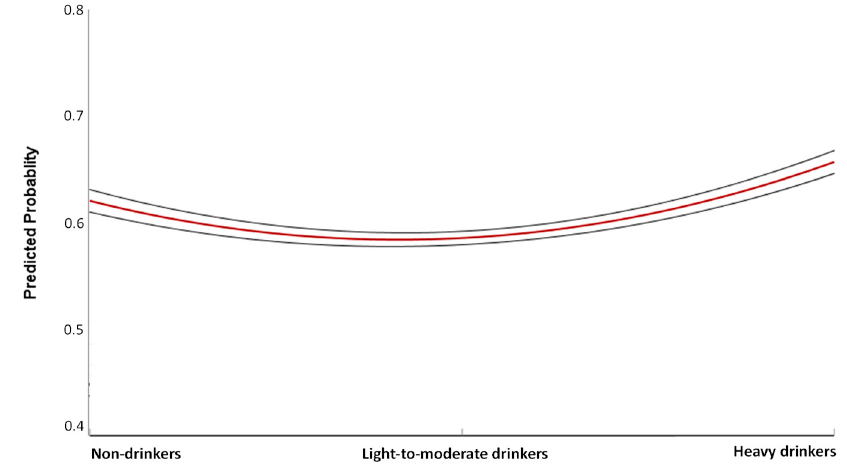
Figure 2. Relationship between categories of alcohol consumption and poor cardiovascular health status. This graph shows the predicted probability (red line) and 95% confidence intervals (grey lines) of poor cardiovascular health status according to categories of alcohol consumption.